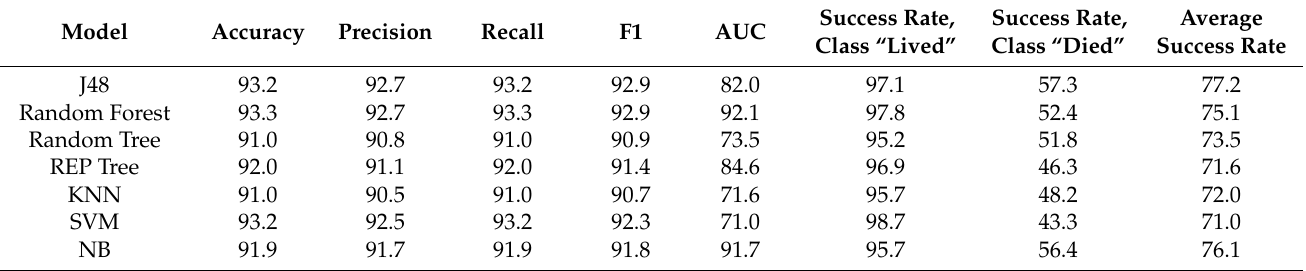
Table 2. Calculated results of average success rate of classification (%).